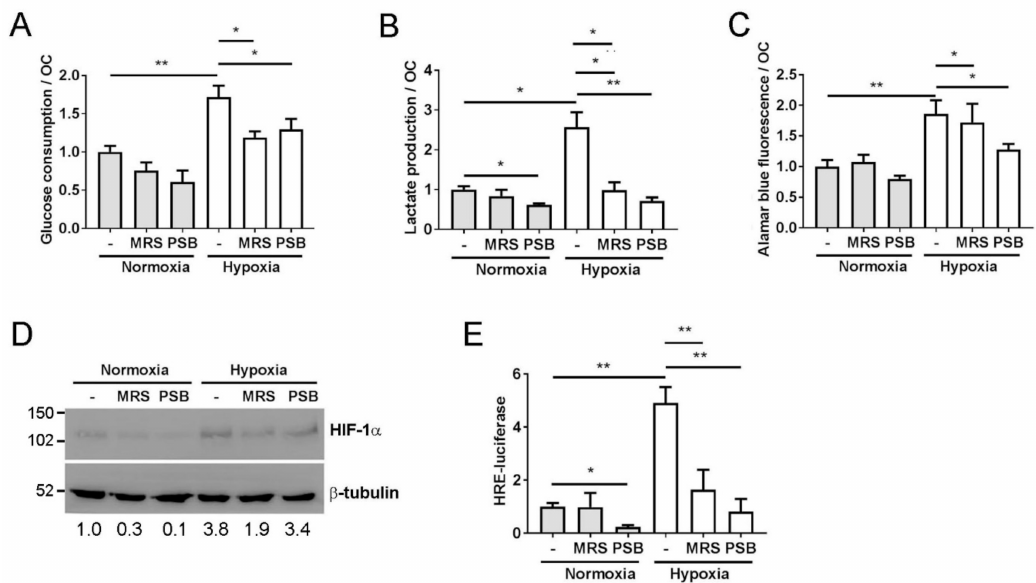
Figure 4. A 2B receptor inhibition prevents the HIF-mediated increase in hypoxic glycolysis. E ff ect of 24 h exposure of mature human osteoclasts to hypoxia (2% O 2 , white bars) and MRS1754 or PSB603 with respect to ( A ) glucose consumption, ( B ) lactate production or ( C ) mitochondrial reductase activity (Alamar blue fluorescence), all per osteoclast ( n = 8). ( D ) Expression of HIF-1 α protein and ( E ) HRE–luciferase activity ( n = 5) after 24 h exposure of mature human osteoclasts to MRS1754 or PSB603 in either normoxic or hypoxic culture conditions. Densitometry for HIF-1 α is presented below the blot; * p < 0.05, ** p <